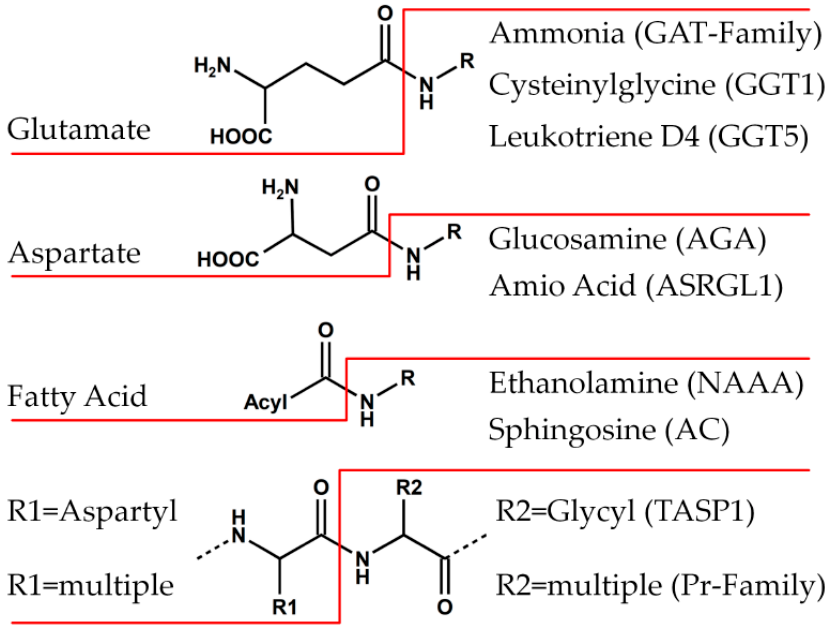
Figure 2. Cleaving products of human Ntn-hydrolases. Substrates of Ntn-hydrolases are cleaved at their amid bonds, releasing cleavage products. While the known carboxylic acid products are either amino acids (glutamate, aspartate, or peptides (Pr family)) or a fatty acid, the amine products show highly diversity (right side).